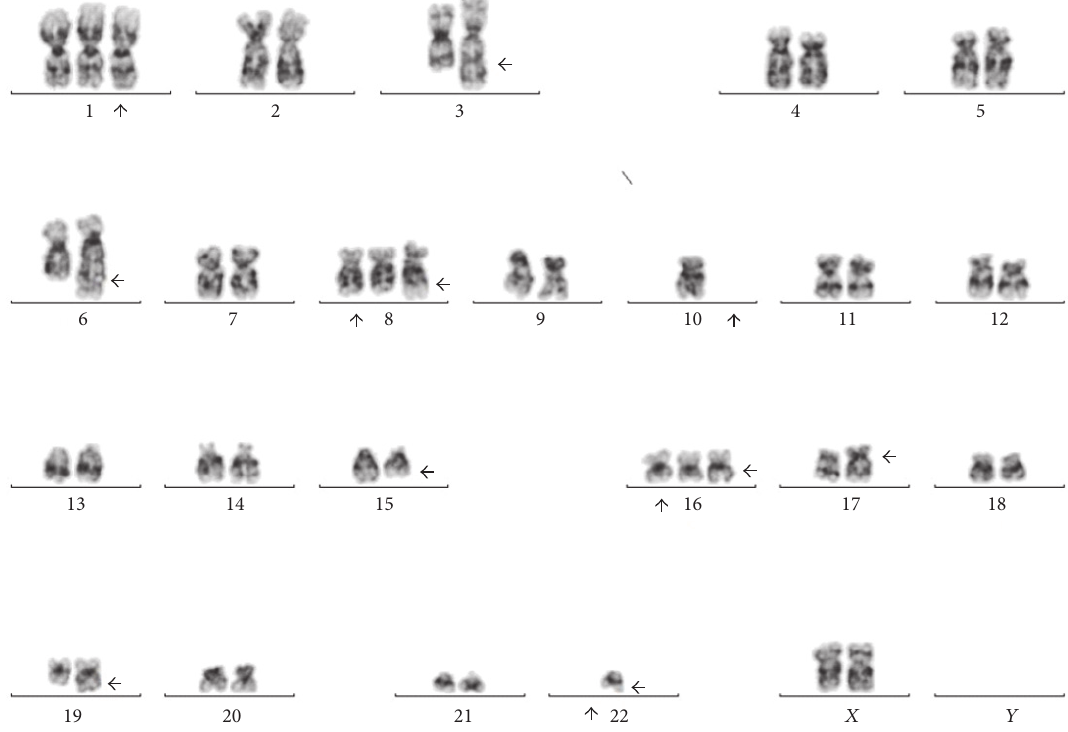
Figure 9: Bone marrow specimen showing 47,XX,+1,add(3)(q21),der(6)t(6;10)(q25;q11.2),+8,t(8;22)(q24.1;q11.2), − 10,add(15)(q22),+16,add (16)(q12-13),add(17)(p11.2),add(19)(q13.1), −